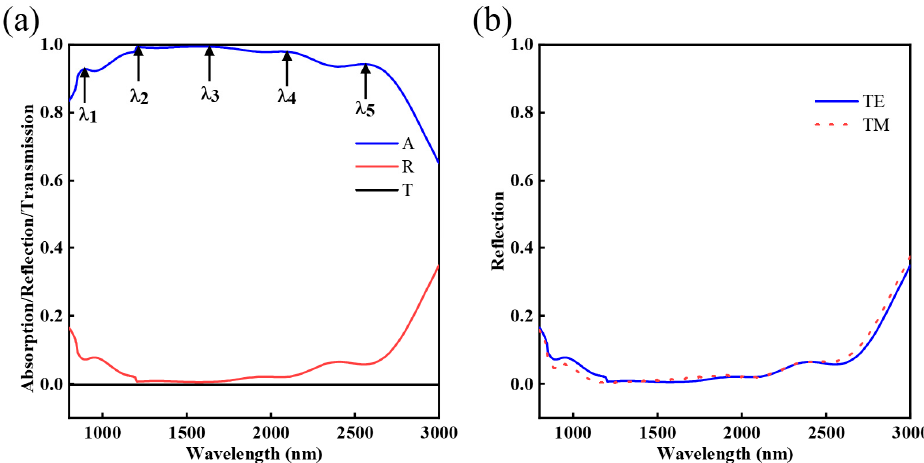
Figure 2. ( a ) Simulated absorption, reflection and transmission spectra of the broadband; ( b ) Reflec- tion spectra in TE and TM polarization modes.